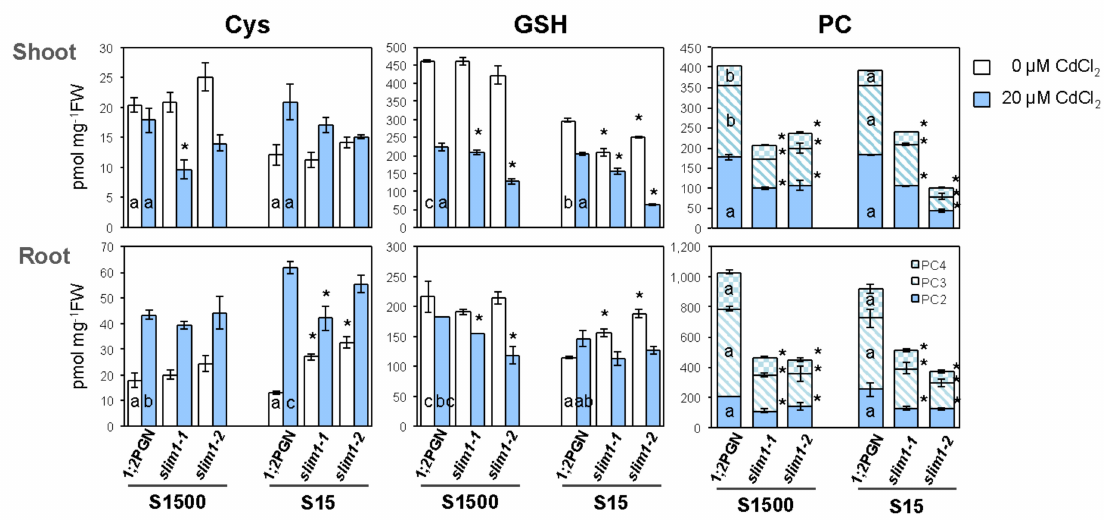
Figure 7. E ff ects of Cd treatment and − S on the content of Cys, GSH and PCs in 1;2PGN and slim1 plants. 1;2PGN, slim1–1, and slim1–2 seedlings were grown for 10 days on MGRL agar medium supplemented with 1500 or 15 µ M sulfate (S1500 and S15) and containing 0 (white bars) or 20 (light blue bars) µ M CdCl 2 . Content of Cys, GSH, and PCs was analyzed by HPLC-fluorescent detection after labeling the thiol bases with monobromobimane. Cys: Cysteine, GSH: Glutathione, PC: Phytochelatin. The average values are indicated with error bars denoting SEM ( n = 3–4). Di ff erent letters indicate significant di ff erences between treatments in 1;2PGN (Tukey–Kramer test; p < 0.05). Asterisks indicate